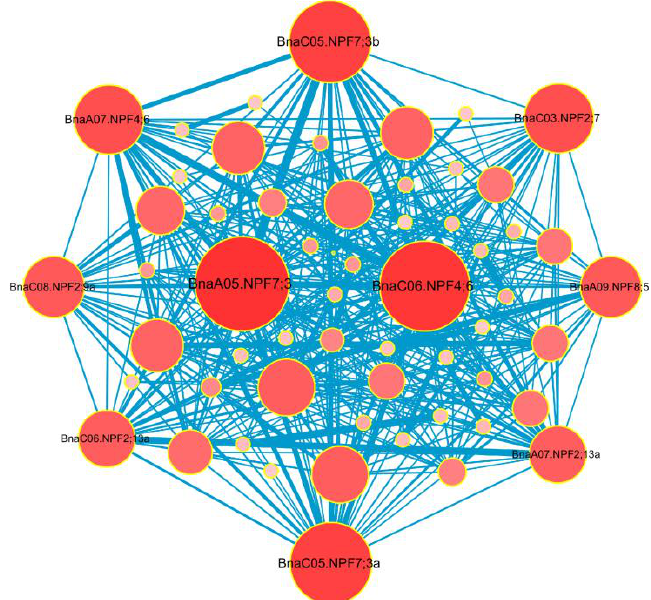
Figure 7. Coexpression networks of the BnaNPF family genes. Cycle nodes represent genes, and the size of the nodes represents the power of the interrelation among the nodes by degree value. The width of the lines between two nodes represents the strength of the interactions between two genes. The hub NPF genes located in the center of the network, while the 10 most coexpressed genes were displayed in network.